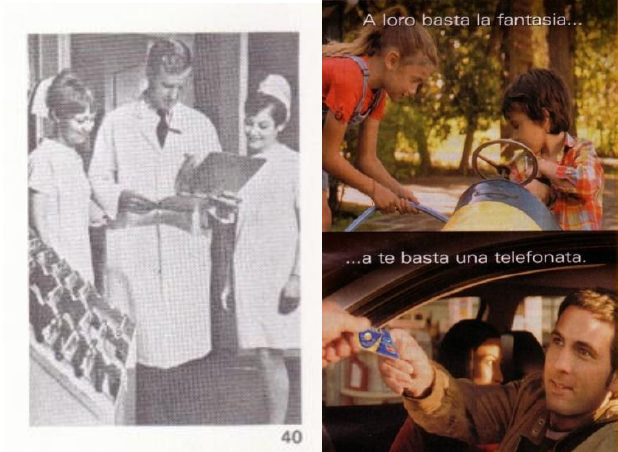
Figure 3. Goffman’s picture and selected picture, The executive role of